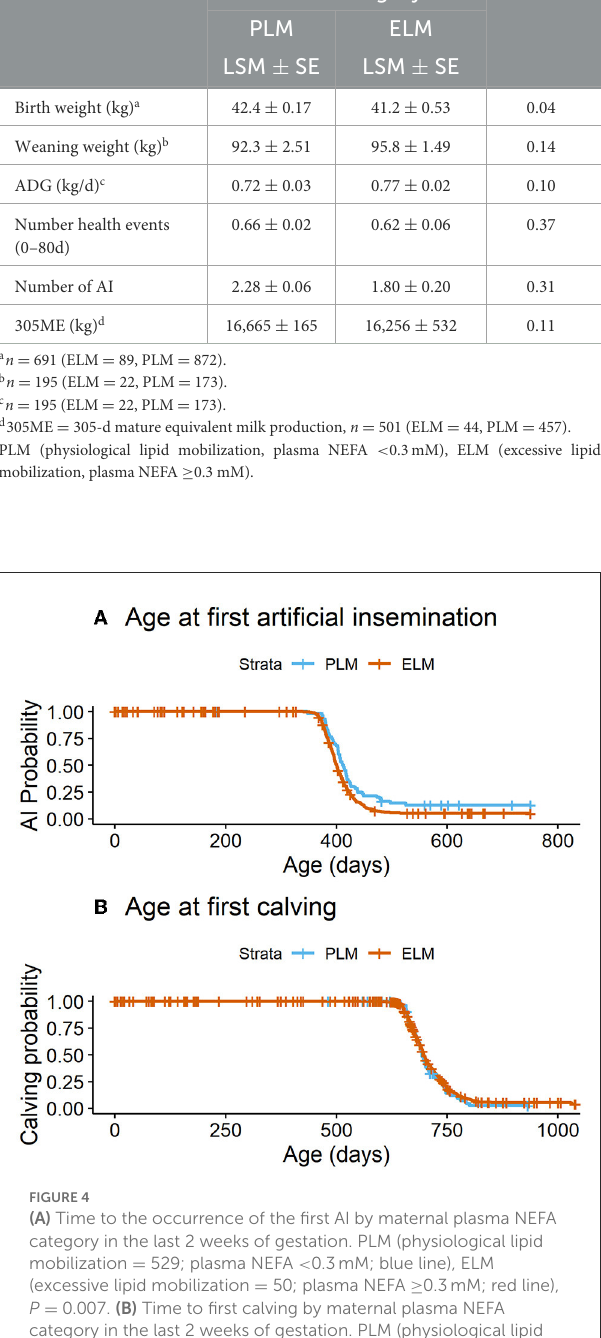
Figure 4B) or in the hazard of first calving between maternal NEFA categories (Table